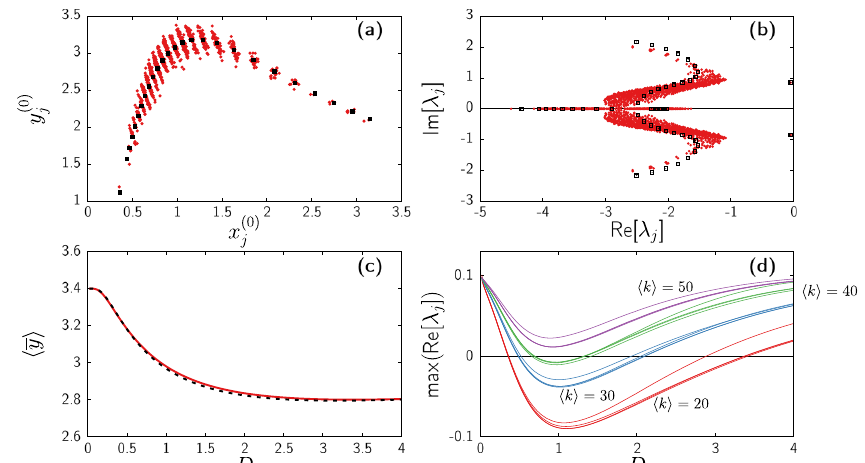
Fig. 6 Heterogeneous mean- fi eld analysis of the Brusselator model. a Phase space for the stationary solution ð x ð 0 Þ j ; y ð 0 Þ j Þ , j = 1, … , N . Red circles correspond to the fi xed point for diffusion value D = 2 as obtained from solving system (4). Black squares correspond to the mean- fi eld result for the same D . b Eigenvalue spectra resulting from stability analysis. Red circles correspond to the eigenvalues λ j , j = 1, … , 2 N , of the original fi xed point for each for D = 2, whereas open black squares indicate the spectra resulting from the mean- fi eld reduction. c Mean- fi eld value of the y variable, y , for the fi xed point. Results obtained from directly solving system (4) (red continuous curve), and from the mean- fi eld reduction (black dashed curve). d Largest eigenvalue ’ s real part for the mean- fi eld solution with ER networks with average degree 〈 k 〉 = 20 (red), 30 (blue), 40 (green), and 50 (purple). For each set of networks each line denotes a different network size. From top to bottom, N = 10 3 , 10 4 , 10 5 , and 10 6